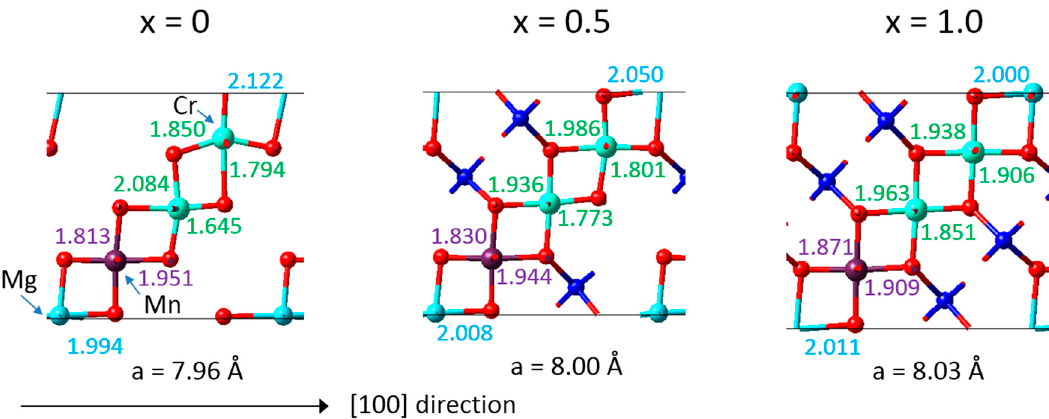
Figure 4. Computed interatomic distances of the compound Li x Mn 1.125 Cr 0.5 Mg 0.375 O 4 for increasing Li concentration. Li, Mn, Cr, Mg and O atoms are given in dark blue, violet, cyan, light blue and red, respectively.